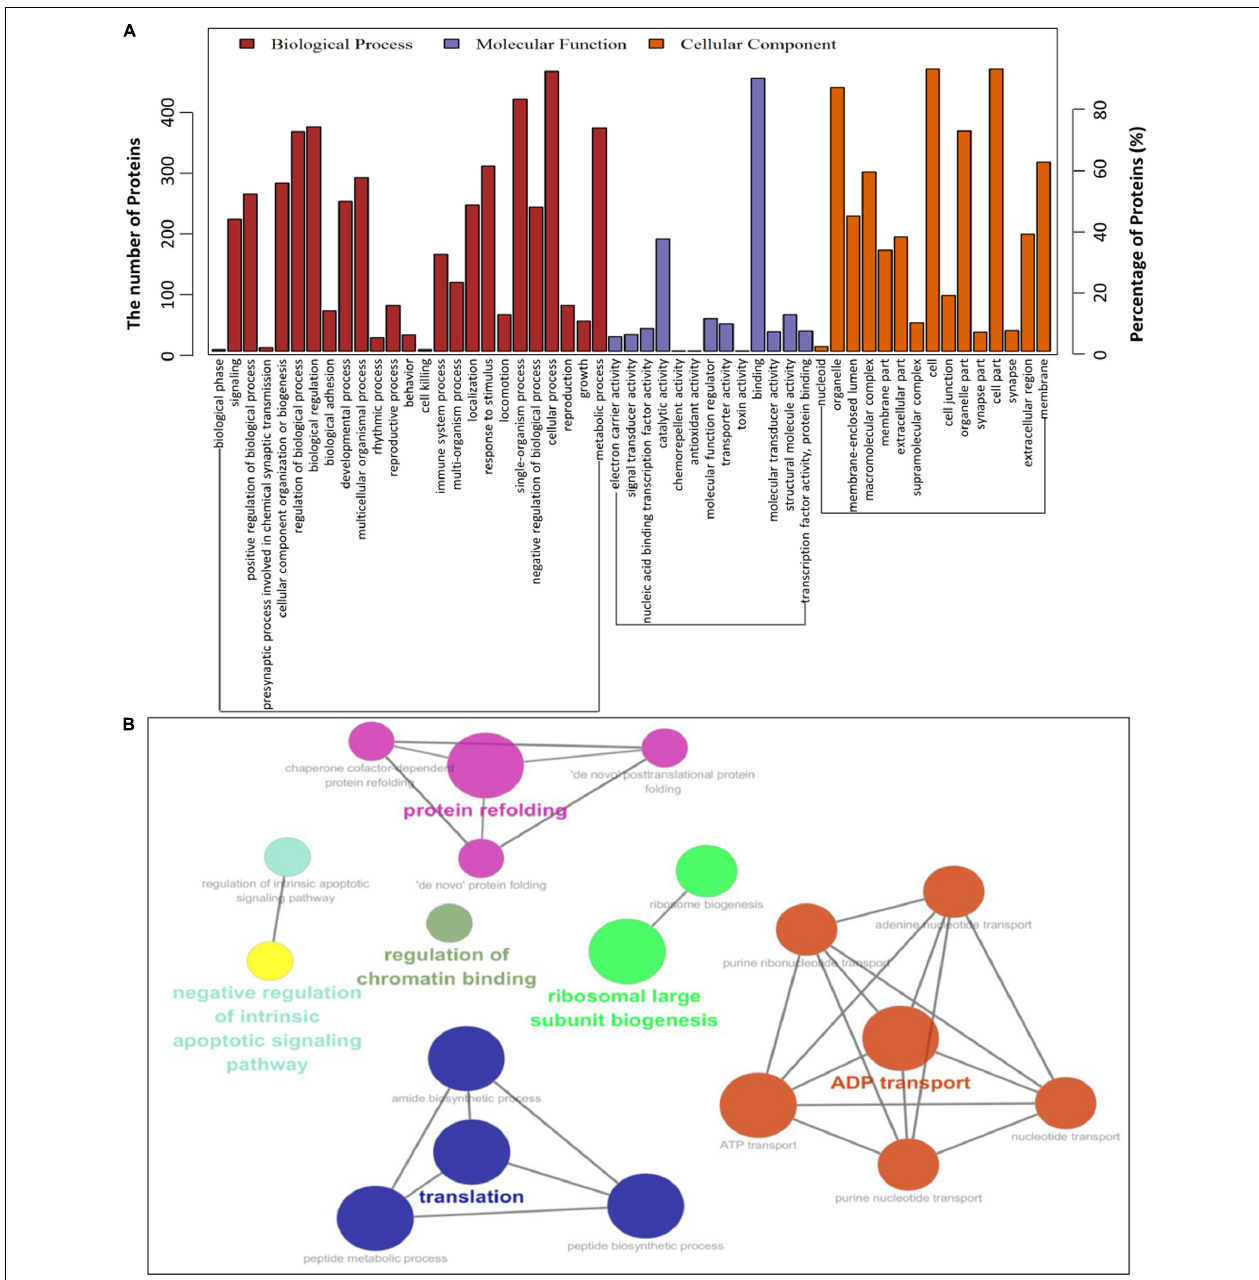
FIGURE 3 | Gene ontology analysis of identified PCV2 Cap-host interactome. (A,B) Representative overrepresented GO terms of protein clusters and the GO distribution of all number of proteins in the PCV2-infected cells versus mock-infected were classified into three categories using software Cytoscape 3.7.1 with plugin GOclue and were shown for significantly enriched terms based on biological process (BP), molecular function (MF), cellular component (CC), p -value < 0.05. The Roman numerals represented the detailed GO terms as shown in Supplementary Tables S3, S5